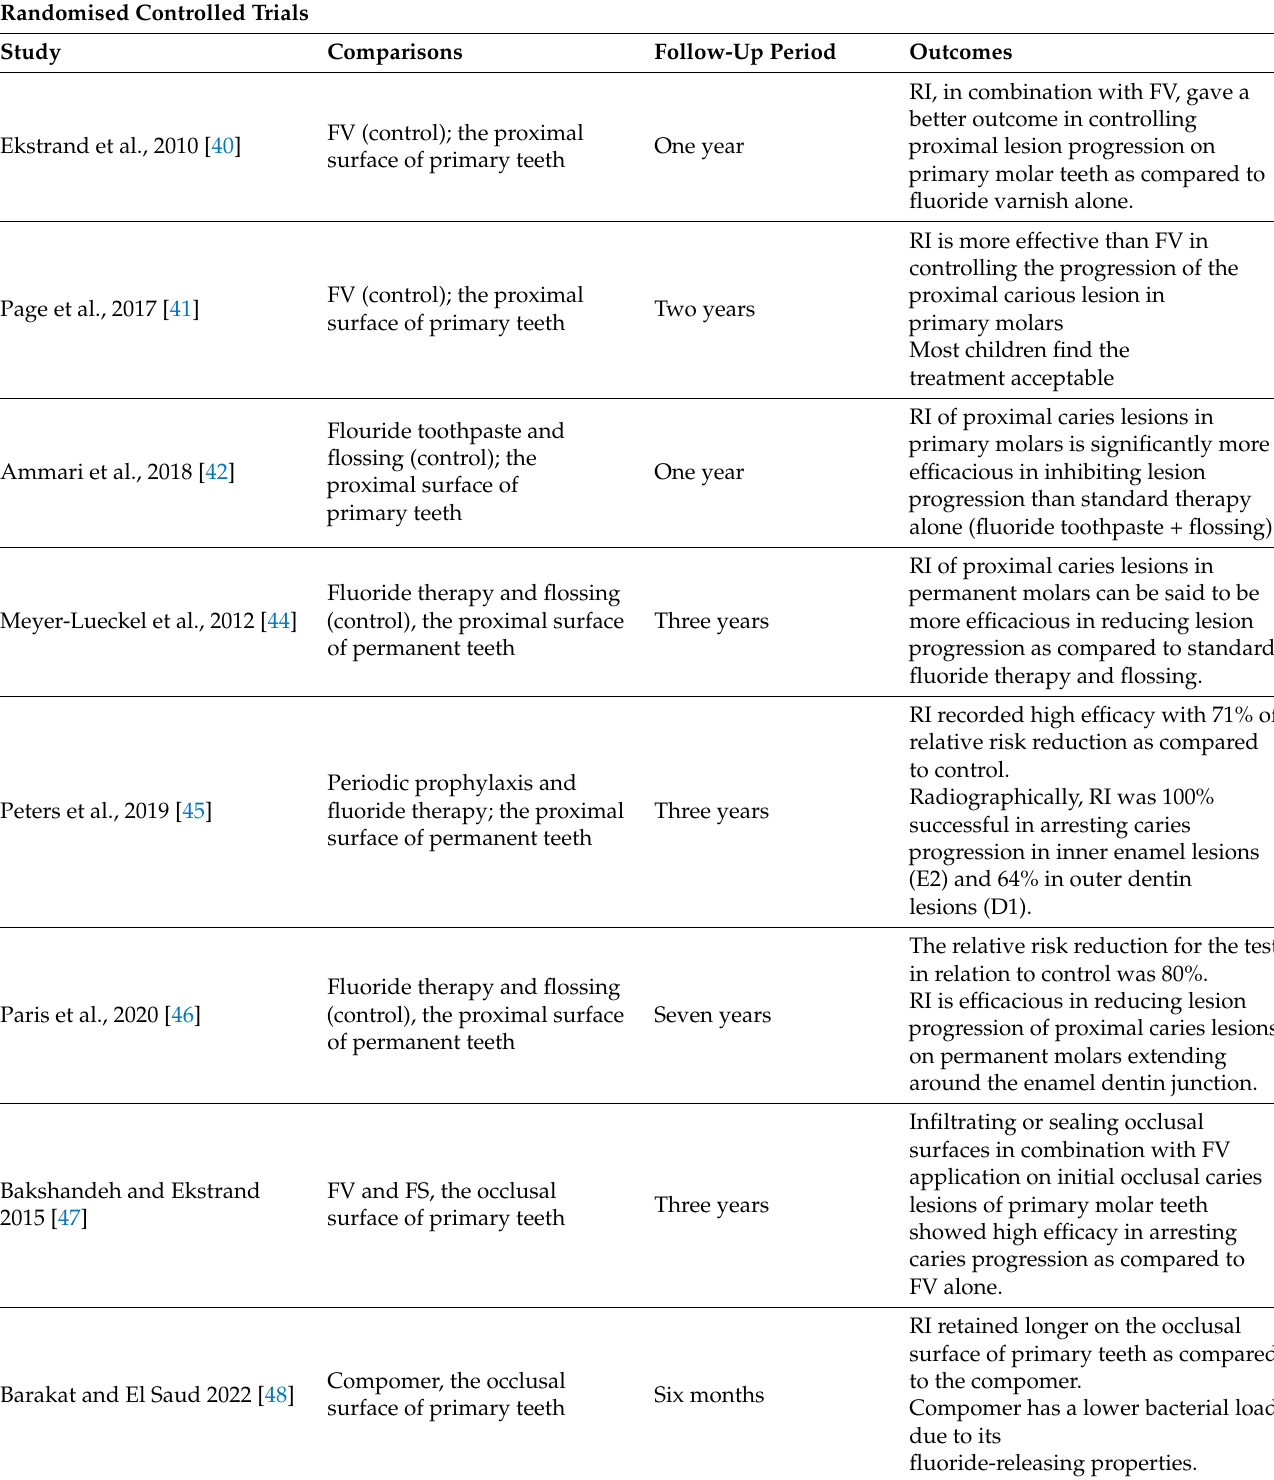
Table 2. Summary of main studies on the ability of RI to arrest non-cavitated early enamel lesions. Randomised Controlled